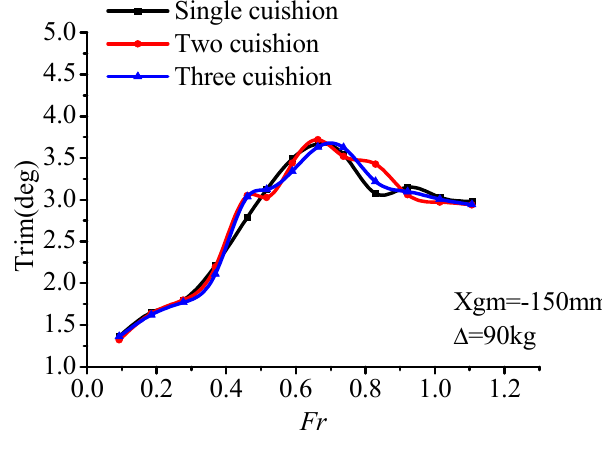
Figure 24. Comparison of models’ sinkage.